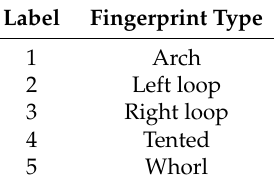
Table 6. Label for generated databases for each fingerprint class.